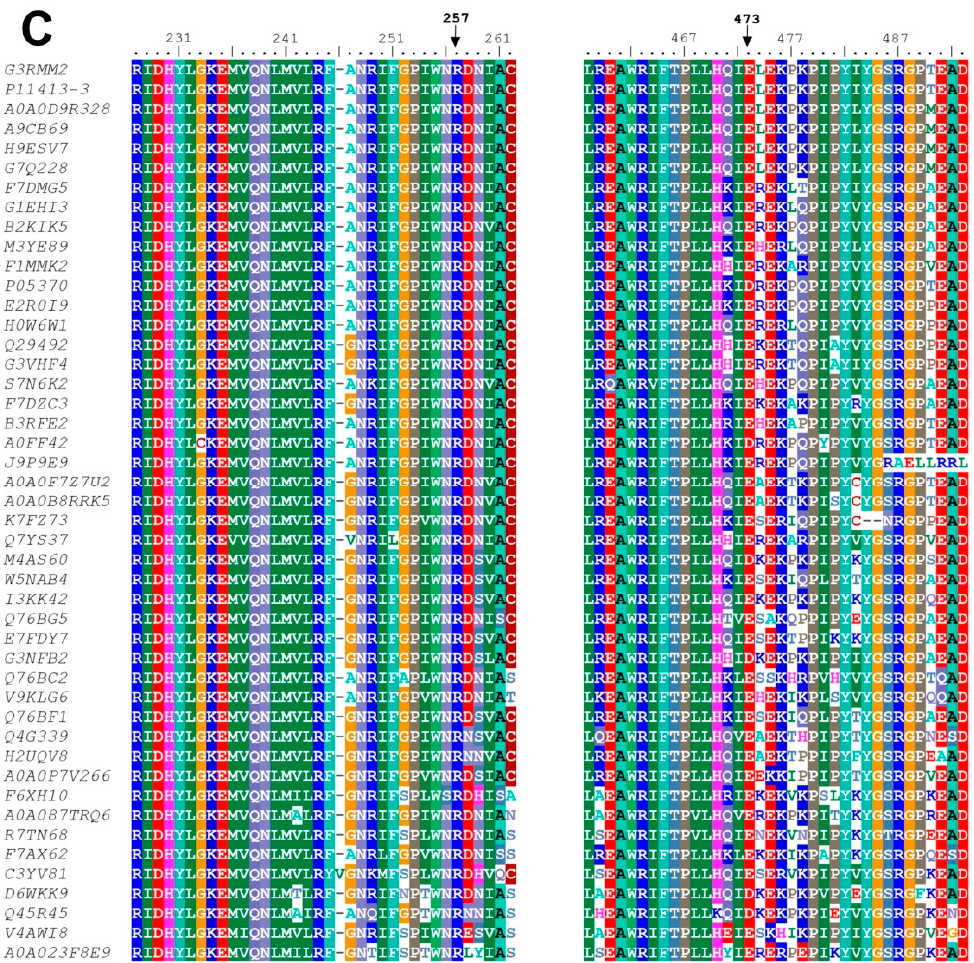
Figure 9. Structural comparison between the human WT G6PD enzyme and the Class I G6PD Zacatecas mutant. ( A ) Crystallographic structure of human WT-G6PD enzyme (pale crimson) (PDB entry 2BH9); ( B ) Minimized model of the Class I G6PD Zacatecas variant (pale crimson) with the in silico R257L mutation. Note that the R257 (black cylinders) residue forms a weak cation– π interaction with W462 and a salt bridge with E473 in ( A ), and their absence in the in silico R257L mutant in ( B ). Distances are in Å; ( C ) Alignment of amino acid sequence of G6PD with homologs from different species from Gorilla gorilla gorilla (G3RMM2), Homo sapiens (P11413-3), Chlorocebus sabaeus (A0A0D9R328), Papio anubis (A9CB69), Macaca mulatta (H9ESV7), Macaca fascicularis (G7Q228), Equus caballus (F7DMG5), Camelus dromedarius (G1EHI3), Rhinolophus ferrumequinum (B2KIK5), Mustela putorius furo (M3YE89), Bos taurus (F1MMK2), Rattus norvegicus (P05370), Canis lupus familiaris (E2R0I9), Cavia porcellus (H0W6W1), Macropus robustus (Q29492), Sarcophilus harrisii (G3VHF4), Myotis brandtii ( S7N6K2 ), Ornithorhynchus anatinus (F7DZC3), Sorex araneus (B3RFE2), Mus caroli (A0FF42), Canis lupus familiaris (J9P9E9), Crotalus adamanteus (A0A0F7Z7U2), Pelodiscus sinensis (K7FZ73), Bos indicus (Q7YS37), Xiphophorus maculatus (M4AS60), Lepisosteus oculatus (W5NAB4), Oreochromis niloticus (I3KK42), Ambystoma mexicanum (Q76BG5), Danio rerio (E7FDY7), Gasterosteus aculeatus (G3NFB2), Cephaloscyllium umbratile (Q76BC2), Callorhinchus mili (V9KLG6), Lepisosteus osseus (Q76BF1), Rhabdosargus sarba (Q4G339), Takifugu rubripes (H2UQV8), Scleropages formosus (A0A0P7V266), Xenopus tropicalis (F6XH10), Stegodyphus mimosarum (A0A087TRQ6), Capitella teleta (R7TN68), Ciona intestinalis (F7AX62), Branchiostoma floridae (C3YV81), Tribolium castaneum (D6WKK9), Rhipicephalus microplus (Q45R45), Lottia gigantea (V4AWI8), Triatoma infestans (A0A023F8E9), Anopheles gambiae (H2KMF3), Apis mellifera (A0A023FG14), Musca domestica (T1PD22), Aedes aegypti (Q0IEL8) performed with BioEdit V.7.2.5. The uniform colors indicate conserved amino acid in the sequences reported. Colorless represent non-conserved amino acid sequences. The arrows indicate the position R257 and E473 residues are highly conserved in different organisms.